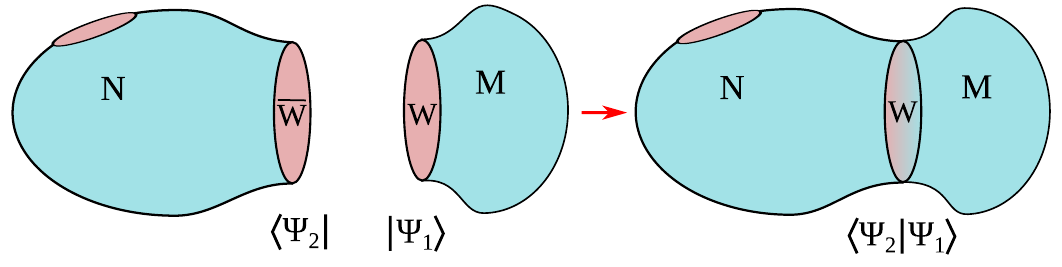
Figure 1 . An illustration of gluing and associated composition of boundary